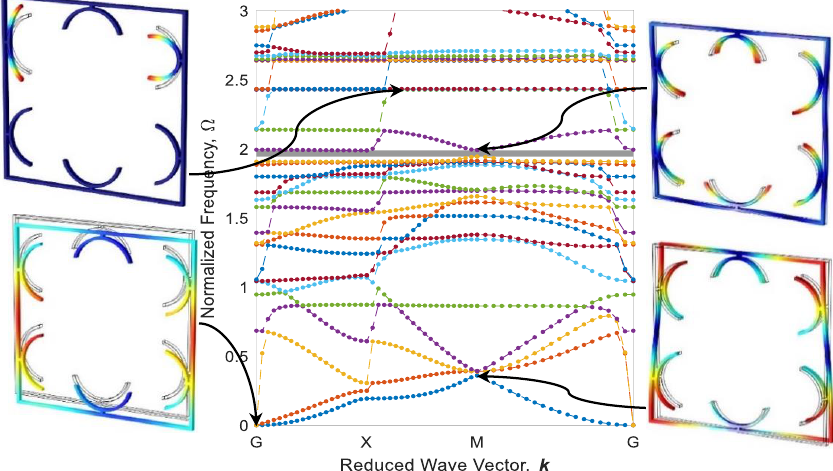
Figure 17. The configuration of adaptive periodic parallel metastructure after heating – cooling process for three different printing speeds: ( a ) 20, ( b ) 40, and ( c ) 70 mm/s.